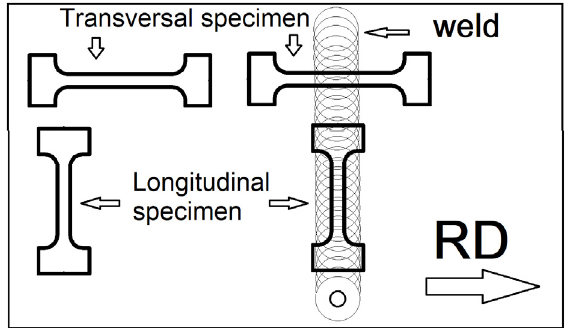
Figure 1. Scheme of cutting the tensile specimens.